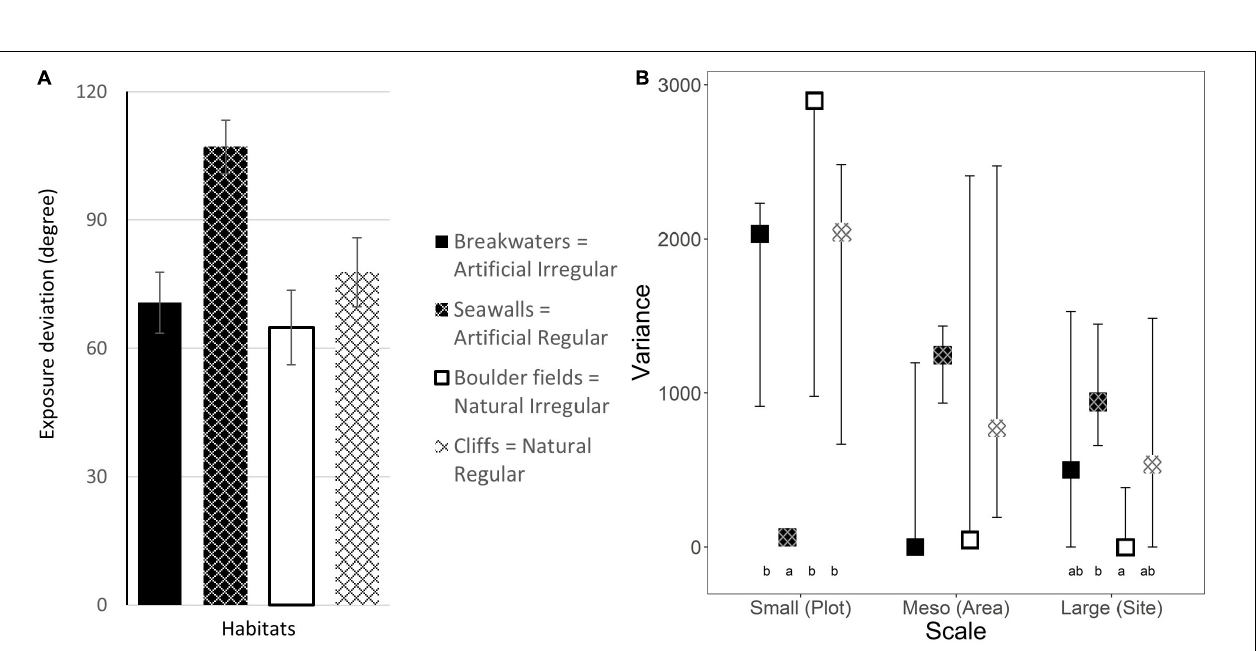
FIGURE 3 | Radar graph representing the frequency (observed/total plots per habitat) of the exposures for the four combinations of habitat Types and Morphologies. The compass values were grouped into 16 major cardinal and intercardinal directions by approximating each point value to the nearest cardinal direction.